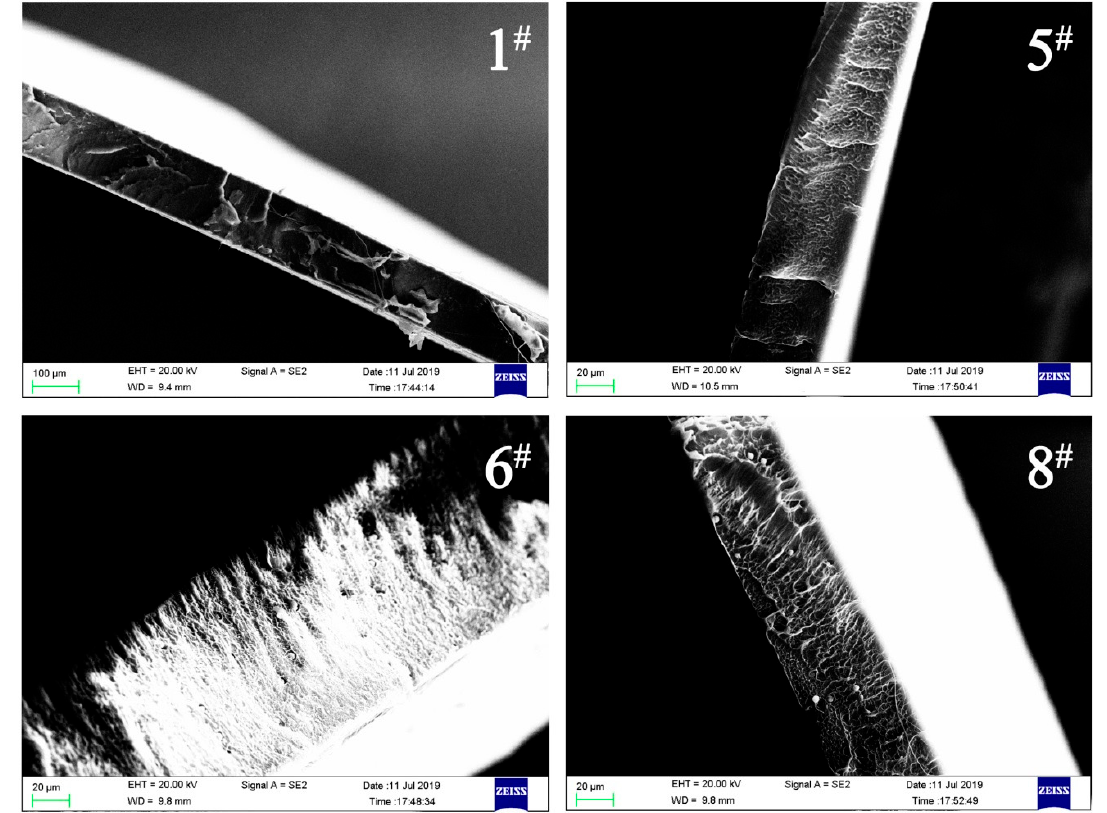
Figure 3. SEM images of the composite films 1 , 5 , 6 , and 8 at different magnifications.